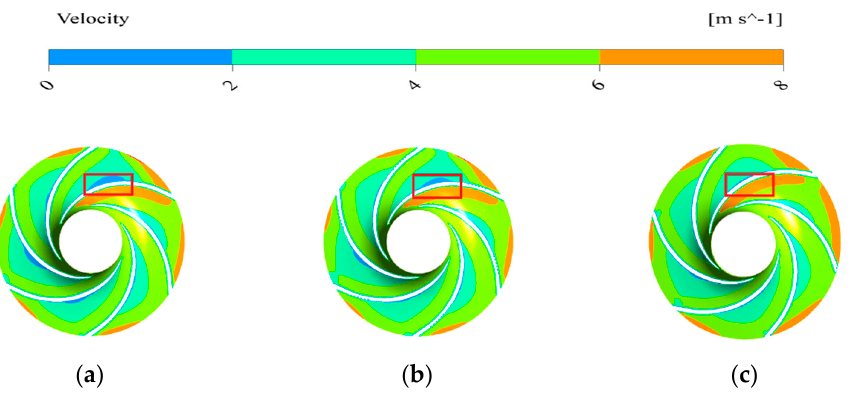
Figure 13. Velocity distribution on the middle section of different models. ( a ) Basic model; ( b ) bionic pit model; ( c ) bionic sawtooth model.